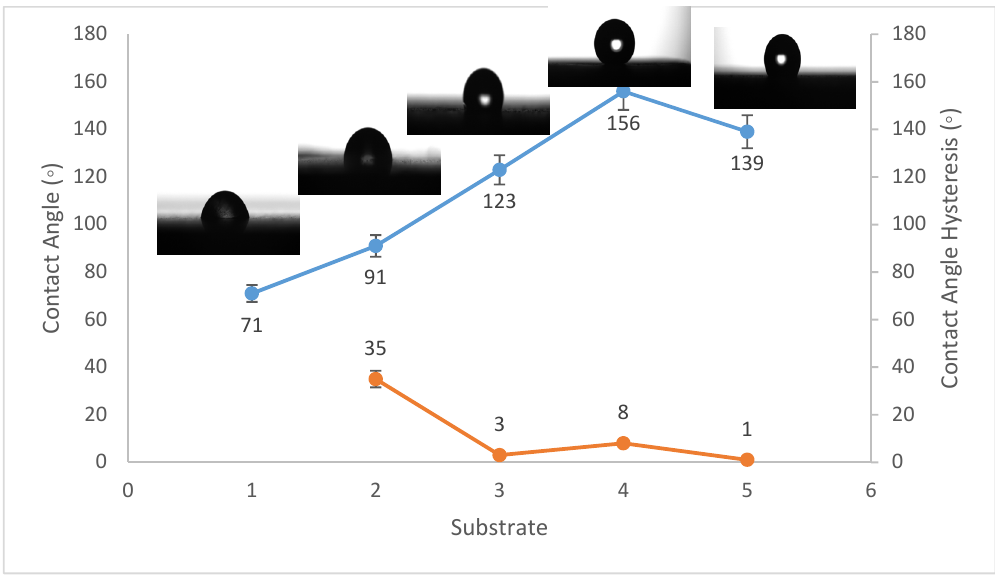
Figure 2. Wettability (WCA and WCAH) of A1, A2, A3, A4, and A5 conditions (Al substrates).